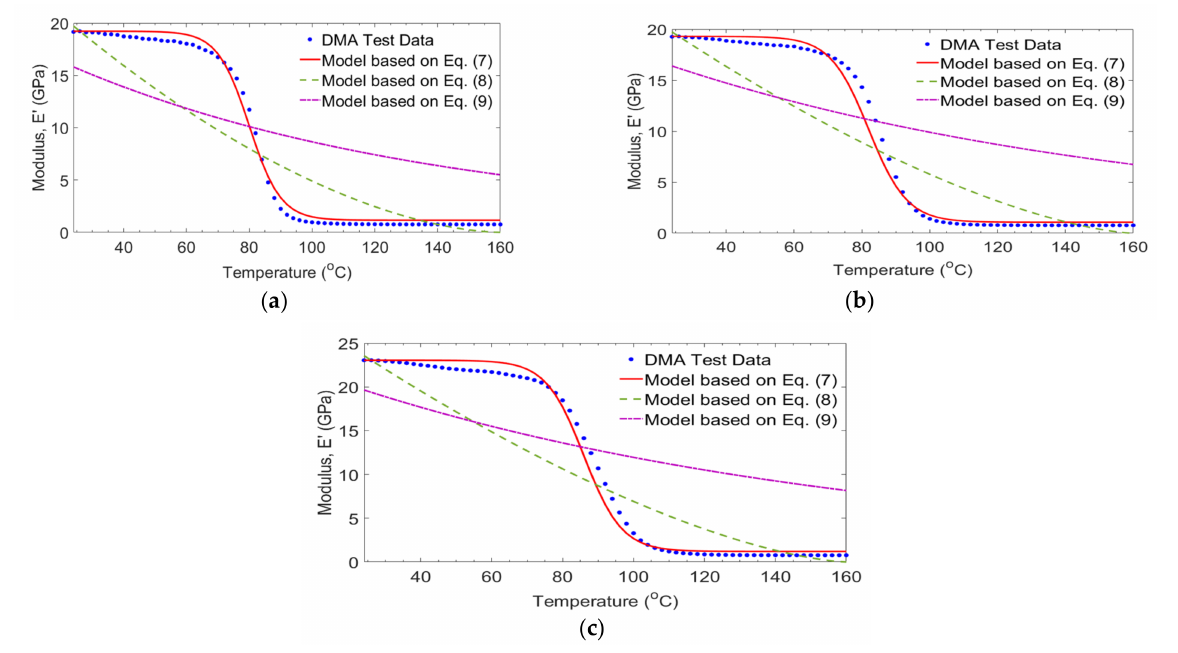
Figure 10. Comparison of test and empirical models for GE (control) laminates at frequencies of 1 Hz